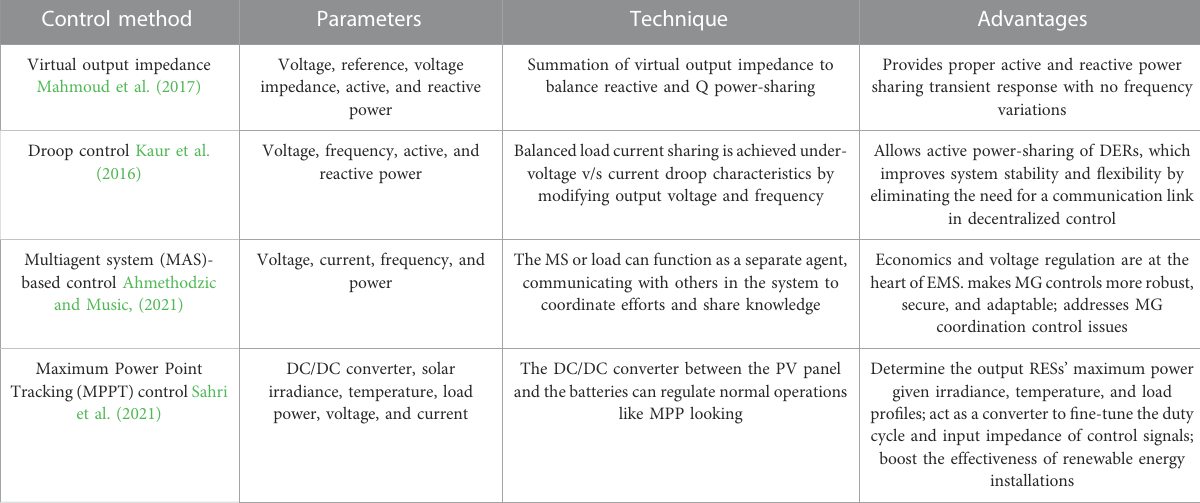
TABLE 2 The conventional control approaches in the microgrid. Control method